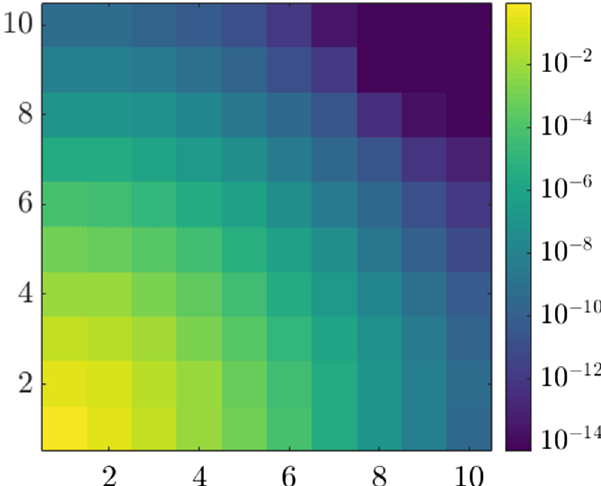
FIG. 13. Single-site occupation of the quantum North-or-East model ground state with s ¼ 0 . 01 on a 10 × 10 lattice. The low- entanglement structure allows us to perform accurate DMRG calculations [94]. Even for small values of s , the ground state exhibits strong